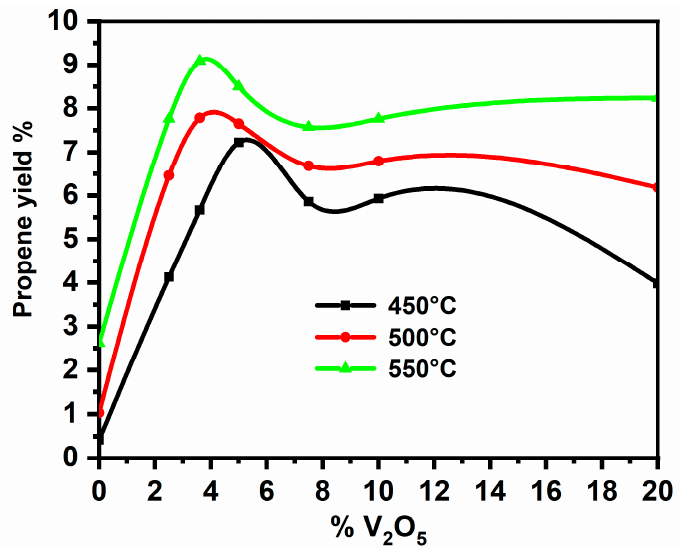
Figure 12. Evolution of the propene yield as a function of the V 2 O 5 content and temperature for a reaction mixture air and propane.